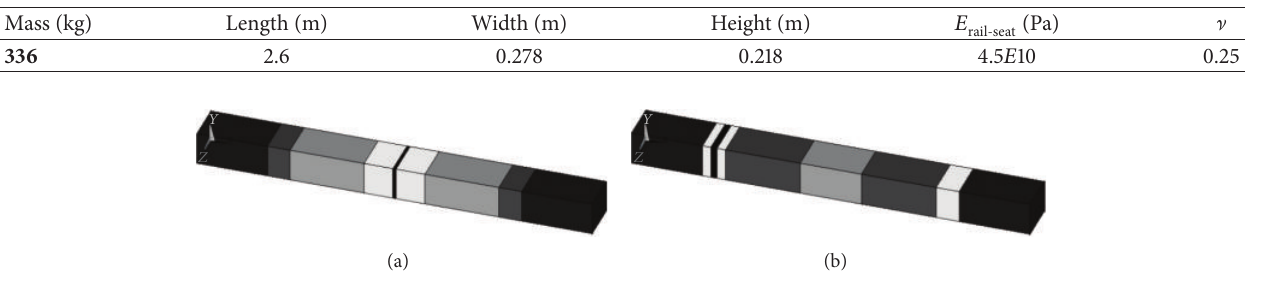
Figure 2: FE of the sleeper cracked at its central section (a) and at rail-seat section (b).